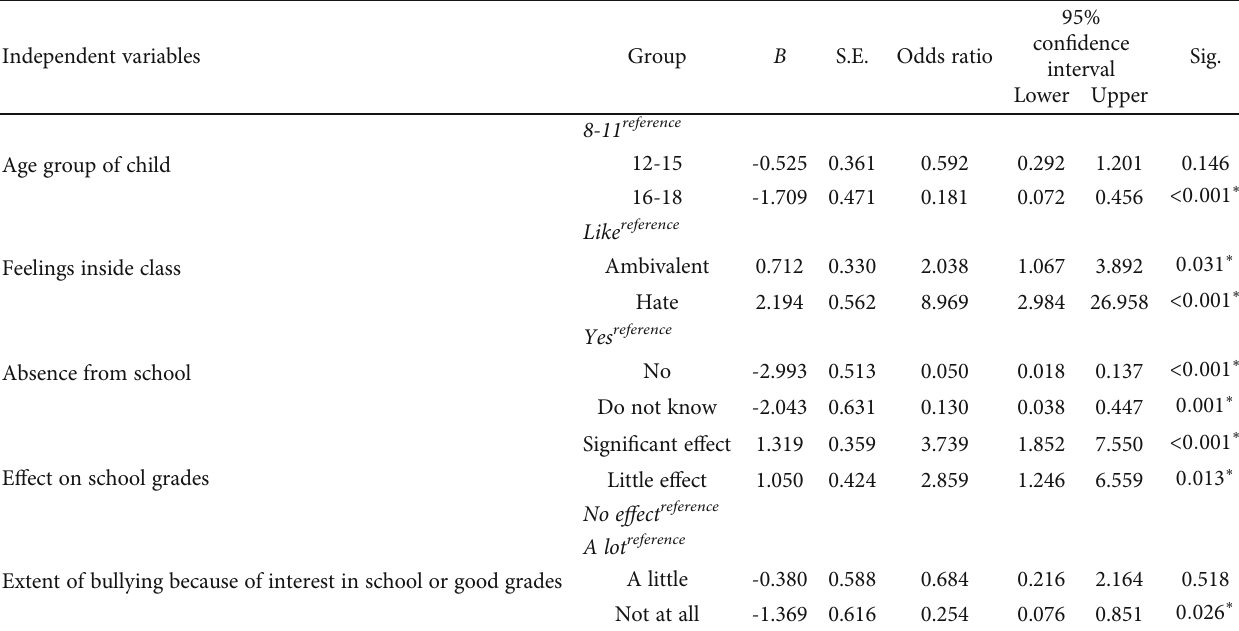
Table 3: Logistic regression analysis of factors associated with bulling